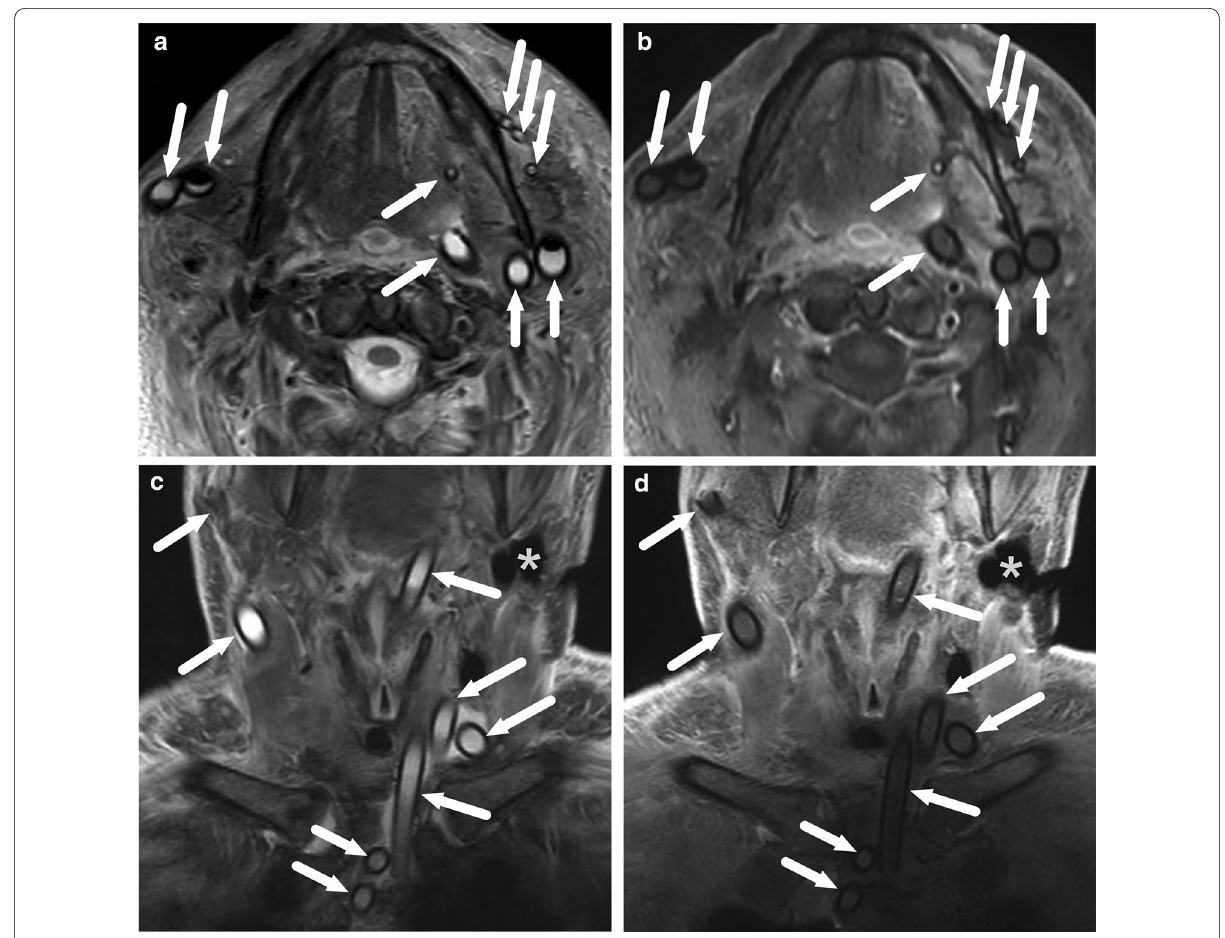
Fig. 30 Post-treatment images of a patient with a severe neck infection, who had a total of 13 drainage tubes (arrows) and wounds intentionally left open (asterisk). Axial ( a ) and coronal ( c ) T2-weighted images and axial ( b ) and coronal ( d ) post-contrast T1-weighted images